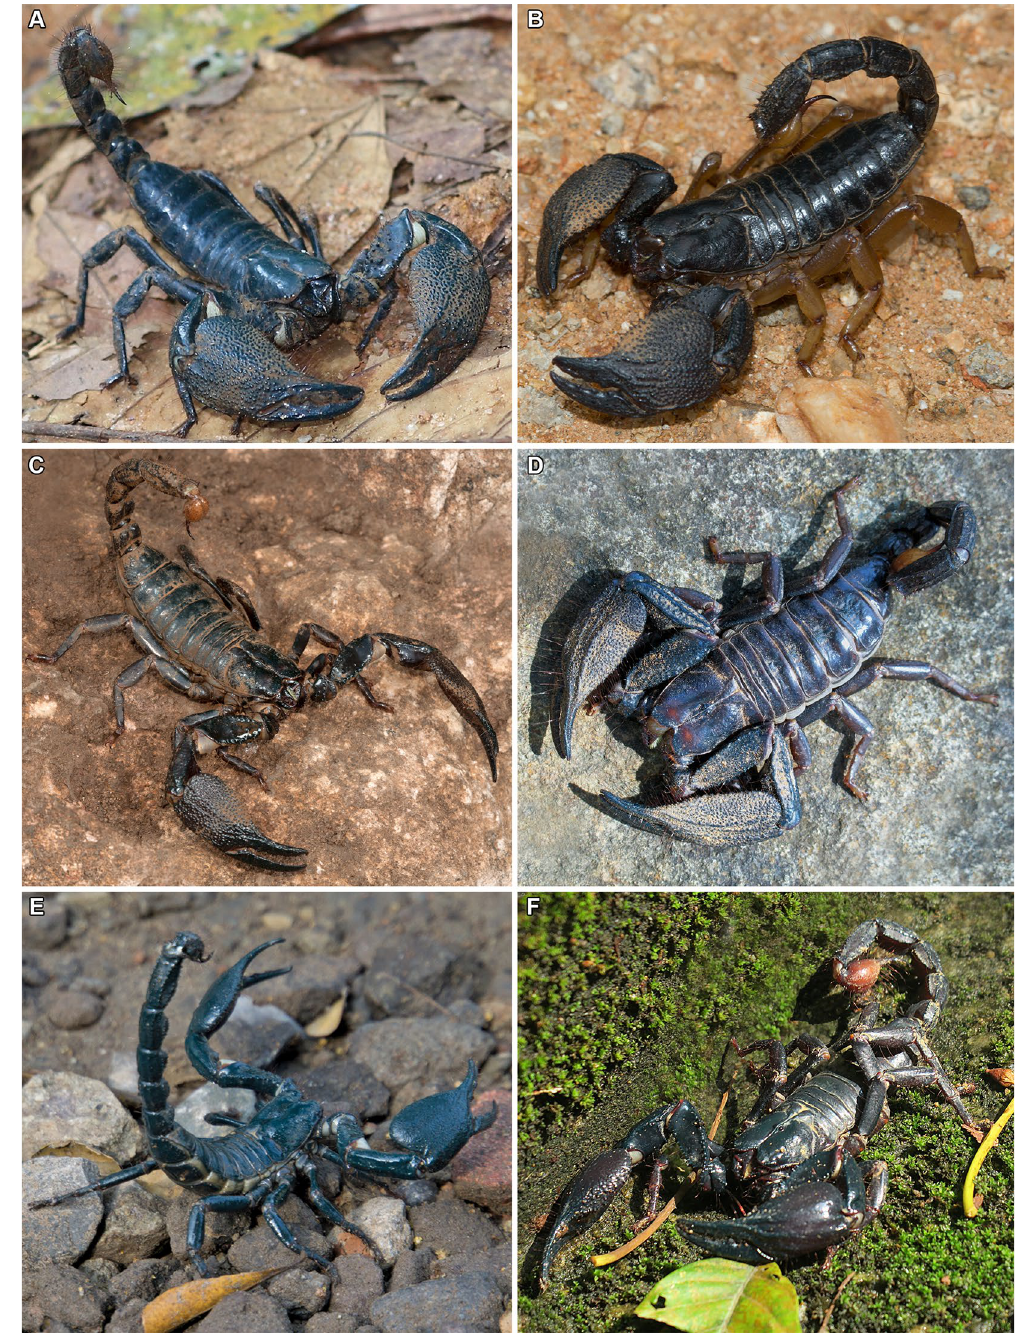
Figure 1. Representative species of Asian forest scorpions (Scorpionidae: Heterometrinae). ( A ) Srilankametrus serratus (Pocock, 1900), ♂ , Sinharaja Forest Reserve, Sabaragamuwa Province, Sri Lanka. ( B ) Chersonesometrus madraspatensis (Pocock, 1900), ♀ , Gautala Wildlife Sanctuary, Maharashtra, India. ( C ) Deccanometrus phipsoni (Pocock, 1893), ♂ , Achanakmar Tiger Reserve, Chhattisgarh, India. ( D ) Chersonesometrus tristis (Henderson, 1919), ♂ , Kaigal Falls, Andhra Pradesh, India. ( E ) Javanimetrus cyaneus (C.L. Koch, 1836), ♂ , Gunung Kidul, Special Region of Yogyakarta, Indonesia. ( F ) Heterometrus petersii (Thorell, 1876), ♂ , Central Water Catchment,